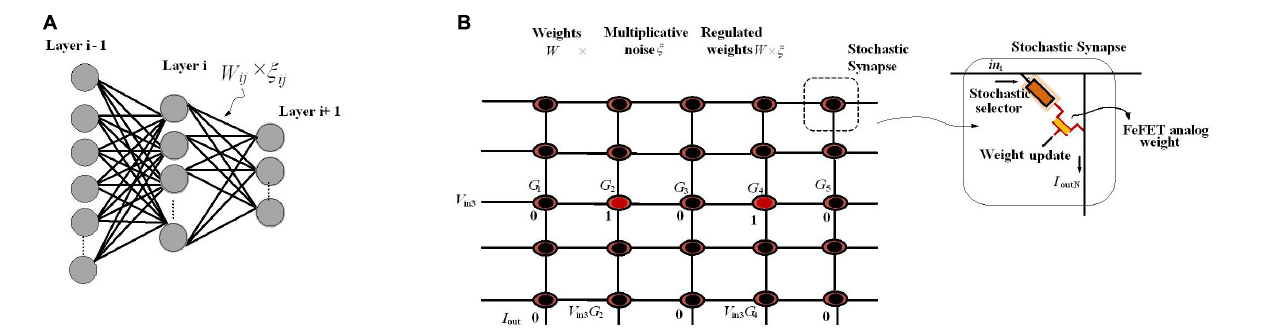
FIGURE 4 | An NSM implemented in hardware using crossbar array architecture. (A) The utilized NSM with an input layer, three hidden layers, and an output layer. (B) The stochastic selector device used for injecting Bernoulli multiplicative noise is placed at each cross-point connected to an analog weight cell implemented using eNVMs. The stochastic selector element provides the selectively sampling or reading the synaptic weights G ij with some degree of uncertainty controlled by random binary variables ξ ij .